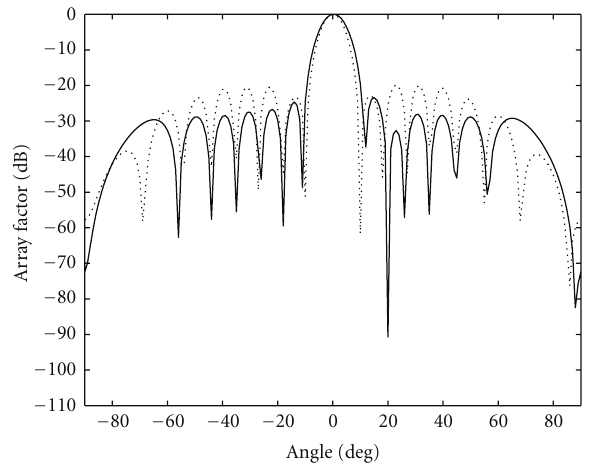
Figure 7: Radiation pattern for failures at 2nd, 3rd, 18th, and 19th element. Dotted curve shows the damaged array pattern and the solid line curve shows the corrected pattern.